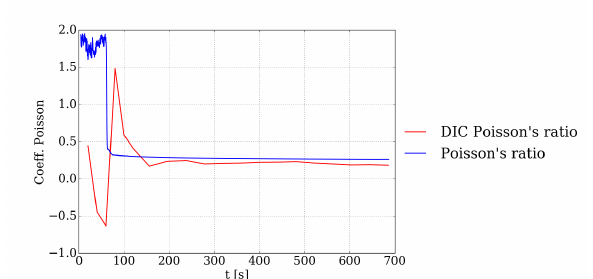
Figure 13: Comparison between the Poisson’s ratio obtained by the DIC method and the strain gauges measurements for sample n. 2.